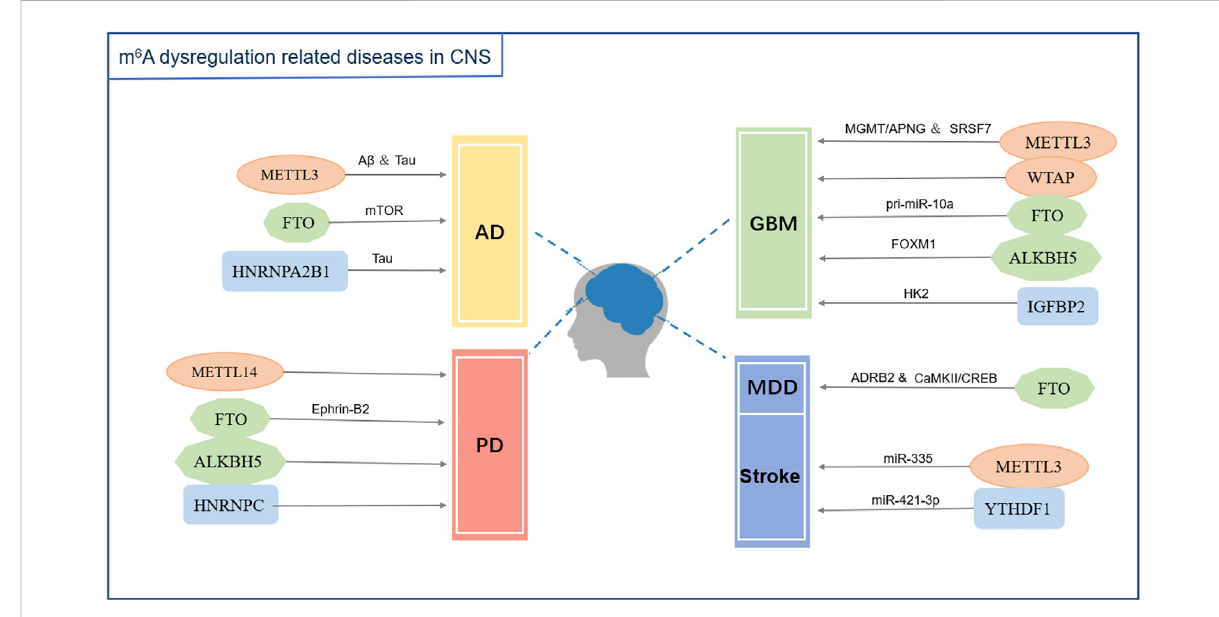
FIGURE 2 m 6 A modi fi cation dysfunction related diseases in the central nervous system. Abbreviations: AD (Alzheimer ’ s disease), PD (Parkinson ’ s disease), GBM(Glioblastoma),MDD (Majordepressive disorder),A β (amyloid- β ),Tau (Tauprotein),mTOR (Mammaliantargetofrapamycinsignalingpathway), Ephrin-B2 (erythropoietin-producing hepatocyte receptor-interacting-B2), MGMT (O 6 -methylguanine-DNA methyltransferase), APNG (alkylpurine-DNA-N-glycosylase), SRSF7 (Serine/arginine-rich splicing factor 7), pri-miR-10a (primary microRNA-10a), FOXM1 (transcription factorFOXM1),HK2(Hexokinase2),ADRB2(Adrenoceptorbeta2),CaMKII(Calcium-calmodulin-dependentproteinkinaseII),CREB(cAMPresponse element-binding protein), miR-335 (microRNA-335), miR-421-3P